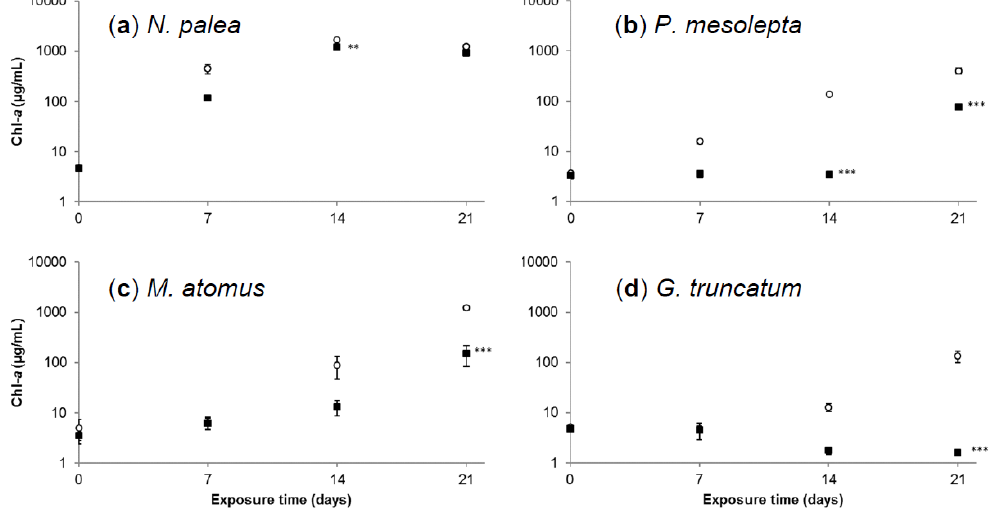
Figure 4. Mean Chl- a concentration in ( a ) N. palea , ( b ) P. mesolepta , ( c ) M. atomus , and ( d ) G. truncatum cultures (μg Chl - a /mL ± standard error) at each exposure time for the cadmium treatment and the control. Stars indicate statistical differences from the control ( n = 3, ** p < 0.01, *** p < 0.001). Black squares represent Cd exposure media (Cd 100 ) and white circles represent the control.